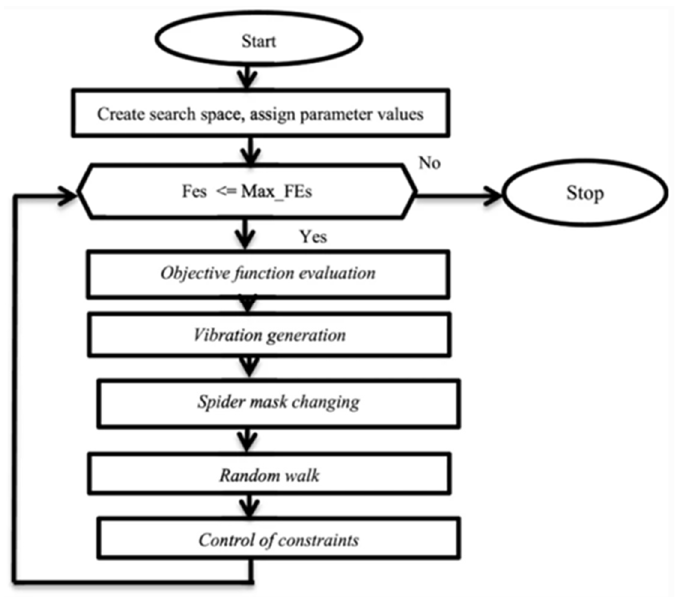
Figure 6. Social Spider Optimization Algorithm, Bas et al . [47].